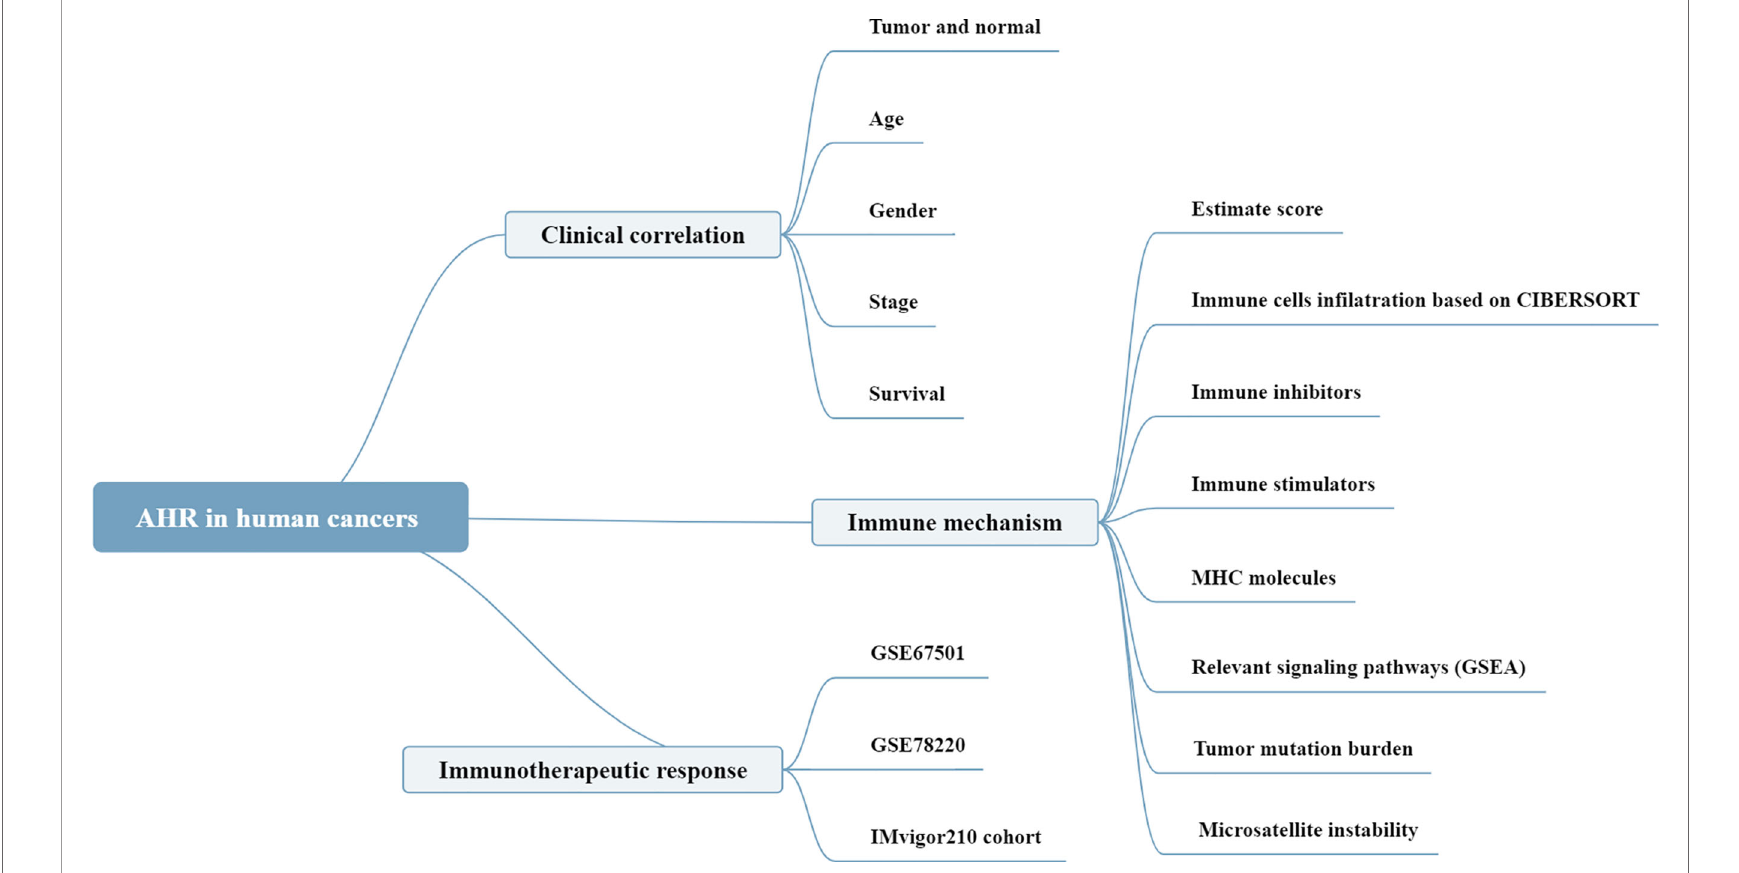
FIGURE 1 | The analyses and indicators employed in our research. In clinical correlation section, differential AhR expression analyses were performed between different tissues (tumor versus normal), ages (<=65 versus >65), genders (male versus female), stages (stage I+II versus stage III+IV). Survival correlation analyses were based on univariate Cox regression analysis. In immune mechanism section, relevant signaling pathways were explored by GSEA based on the AhR expression. In immunotherapeutic response section, Wilcoxon test was performed based on the AhR expression of non-responder and responder